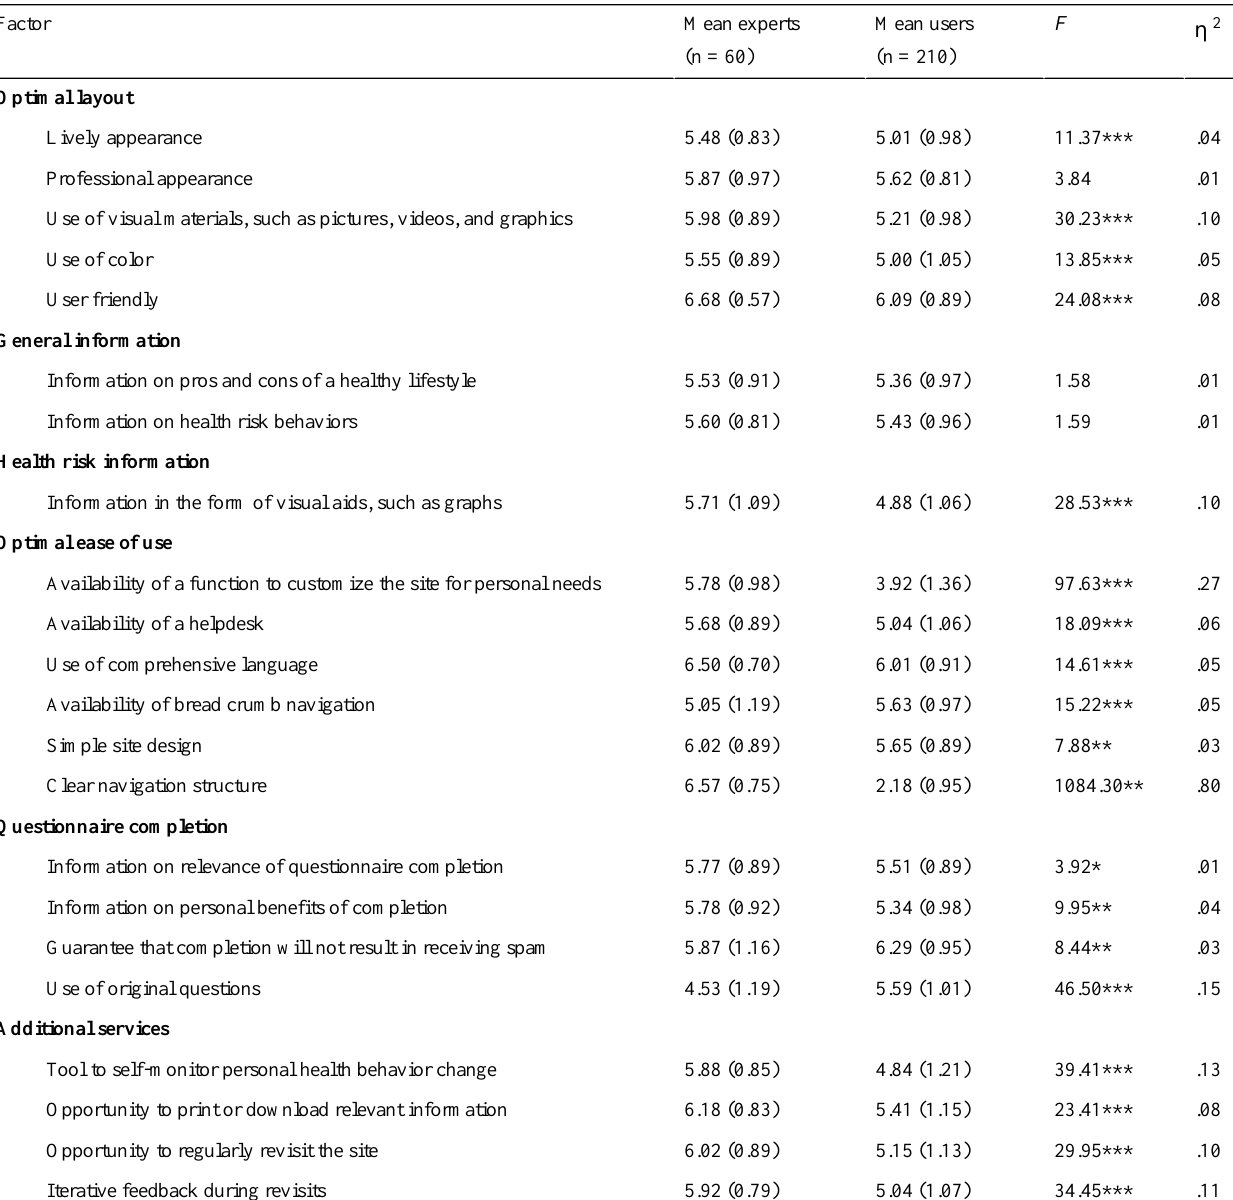
Table 4. Univariate F tests for differences in rating the importance of a factor between experts and